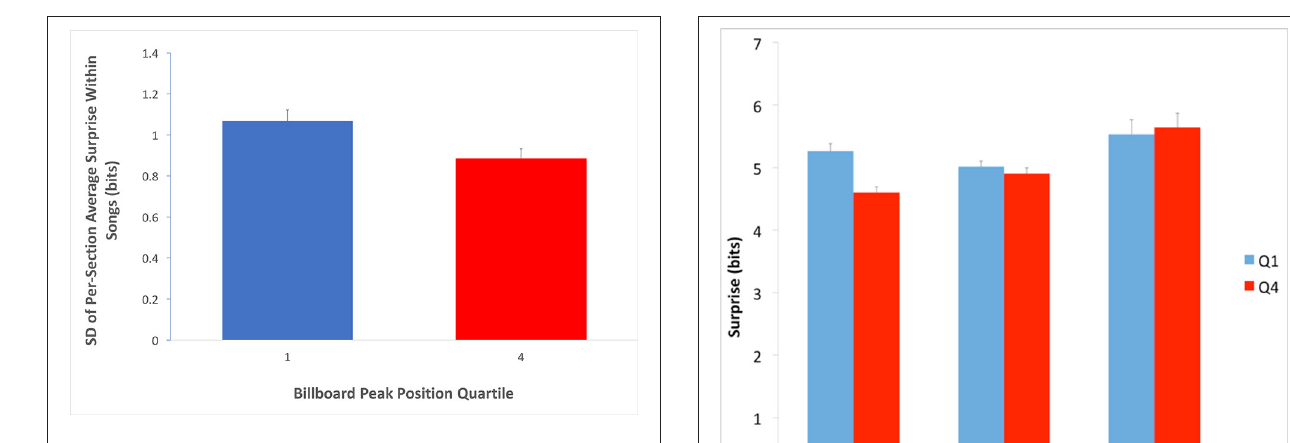
FIGURE 6 | Evidence for the Contrastive-Surprise Hypothesis. Average per-quartile standard deviation across sections within songs (Equation 6, with κ set to “whole song”). Error bars are standard errors. The average surprise of sections within Q1 songs varies more than that of sections within Q4 songs. This finding is consistent with the Contrastive-Surprise Hypothesis. FIGURE 7 | Average surprise across Q1 and Q4 verses, choruses, and